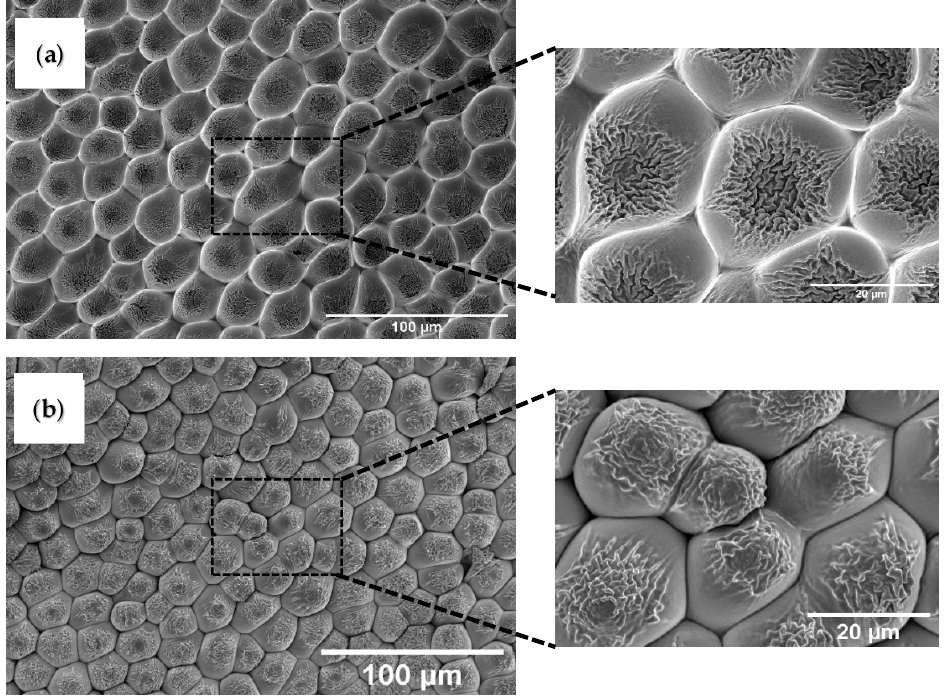
Figure 2. Scanning electron micrography (SEM) images of negative and positive replicas of rose petal structures. ( a ) Image represents the negative replica fabricated on NOA61 film and ( b ) image represents the positive replica fabricated on PUA film.